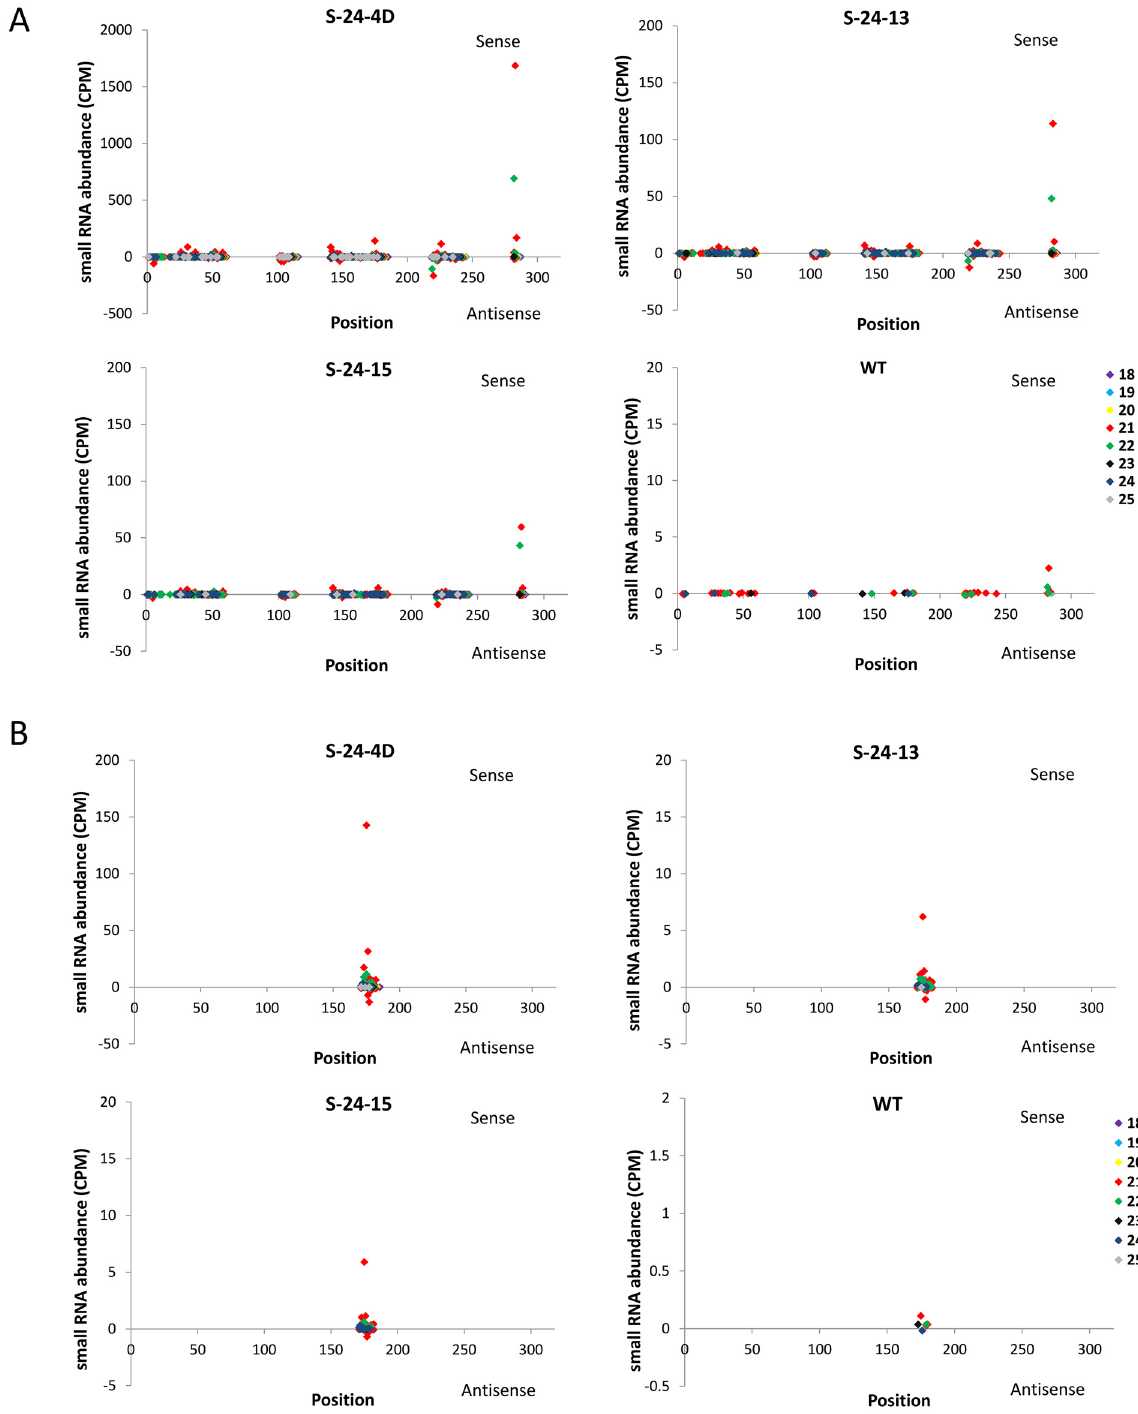
Fig 6. 318-bp IR-derived siRNAs targeting FAD3B and FAD3C . (A) and (B) Small RNAs generated from the 318-bp IR matching the corresponding FAD3B and FAD3C target regions were plotted versus the average of their normalized abundance from three replications, respectively. For visual clarity, Y- axis of each diagram is adjusted according to the small RNA